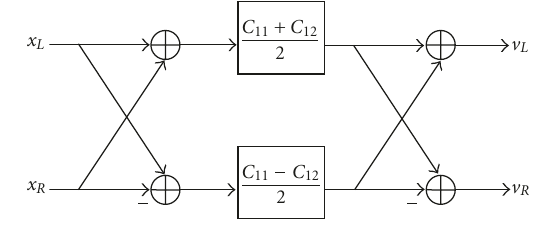
Figure 10: Shu ffl er filter structure for 2x2